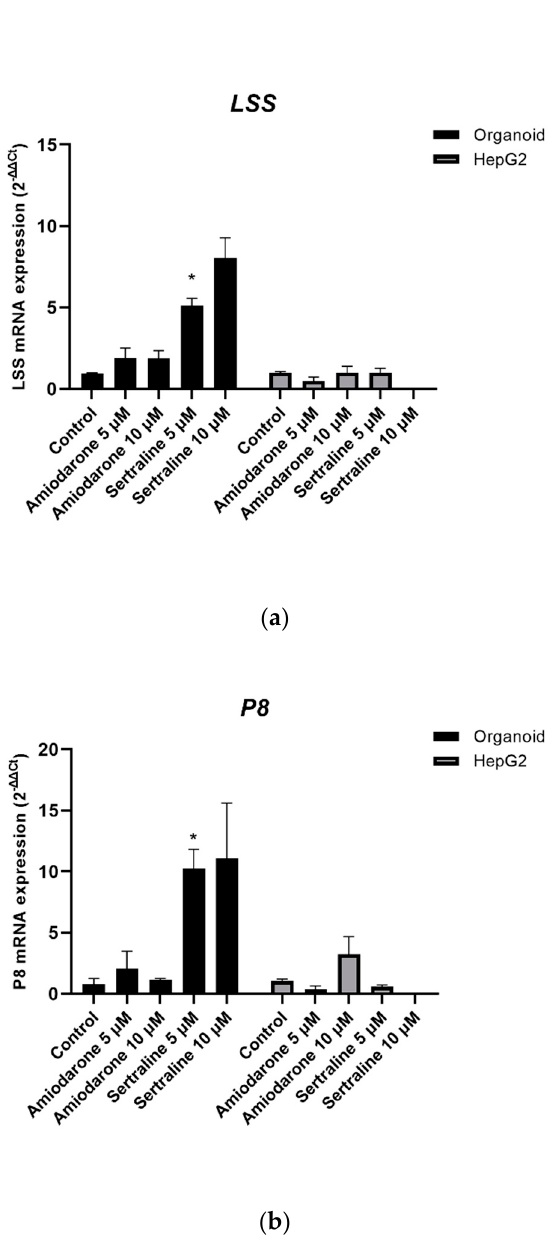
Figure 10. Fold changes in the gene markers of phospholipidosis in organoids and HepG2 cells. Fold changes were measured by the 2 − ∆∆ C t values of gene markers ( a ) LSS and ( b ) P8. mRNA fold changes are shown as a mean ± standard error; * p < 0.05. The experiments were performed in triplicate, each being repeated at least three times.